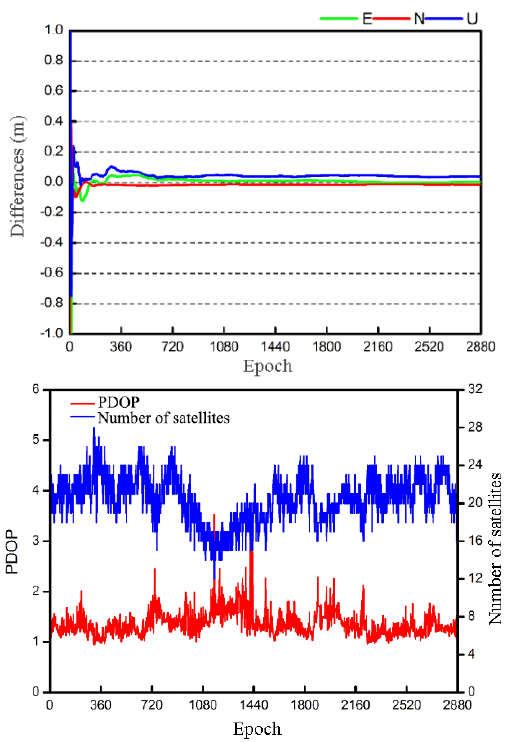
Figure 6. Position deviation and observation of G/R/C combined PPP.